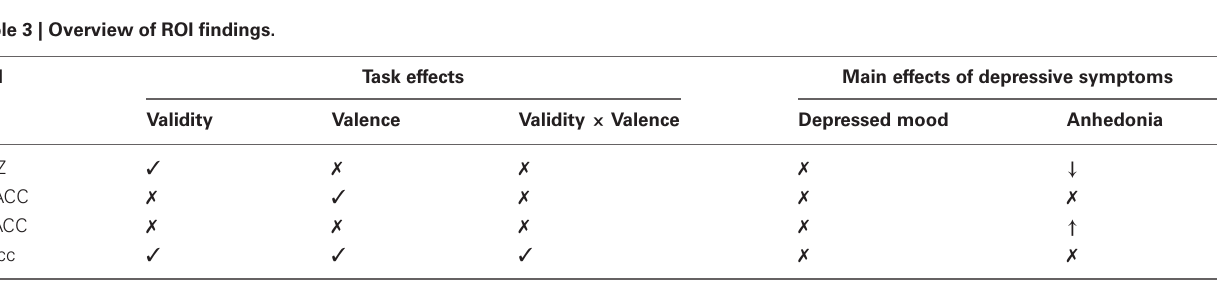
Table 3 | Overview of ROI findings.